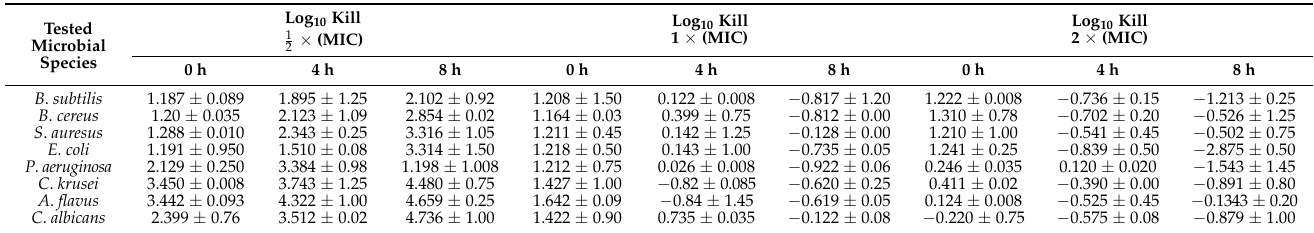
Table 7. In vitro time kill assay of gemm extract of H . griffithi